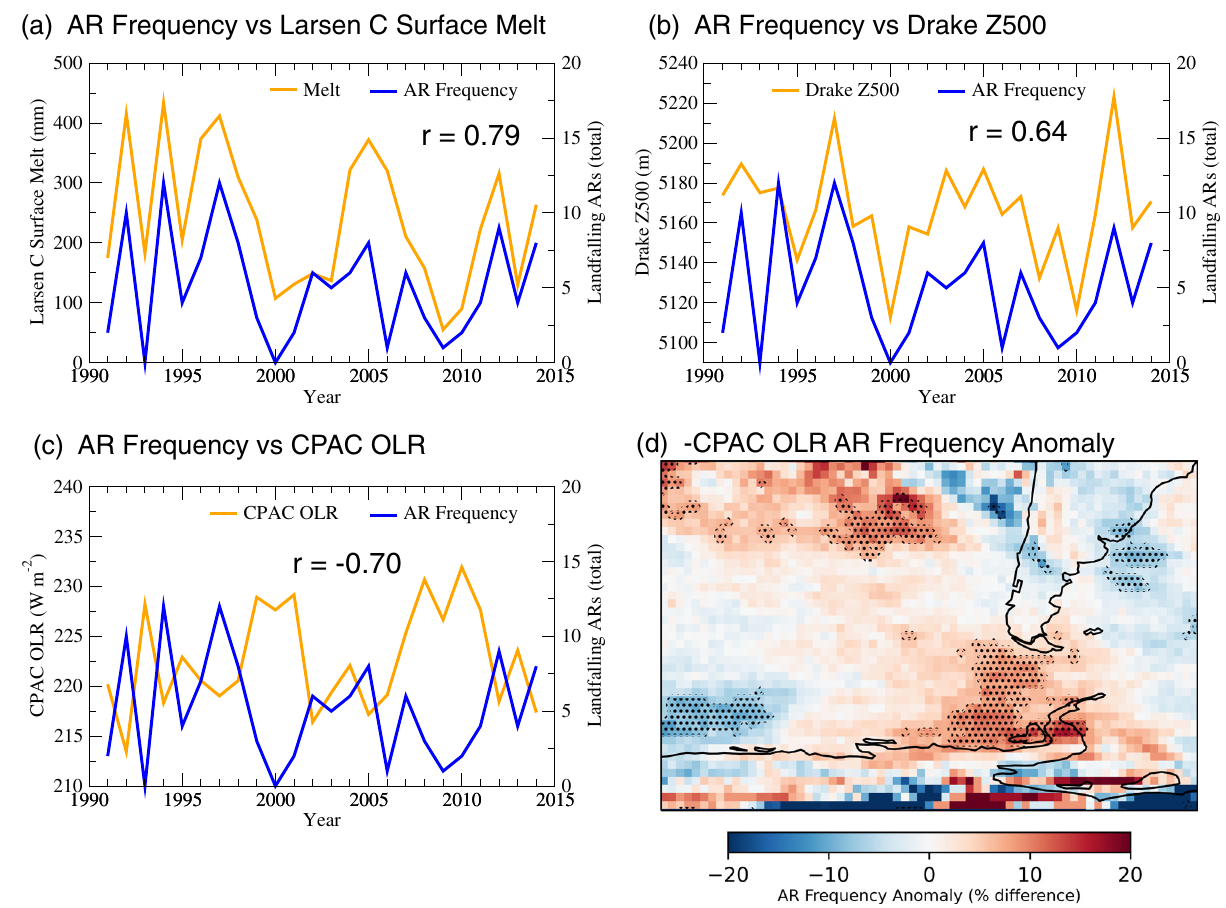
Fig. 6 CPAC convection a key driver of extreme atmospheric rivers on the Antarctic Peninsula. a – c Timeseries of (blue) the total number of DJFM extreme landfalling ARs alongside the (orange) DJFM a Larsen C total surface melt, b Drake Z500, and c CPAC OLR. Inset is the correlation coef fi cient between the two timeseries. d Composite anomaly of AR frequency for anomalous CPAC convection days (daily CPAC OLR ≤ − 0.5 σ ) showing the percentage difference relative to the DJFM AR frequency climatology. Stippling in ( d ) denotes anomalies signi fi cant at p <